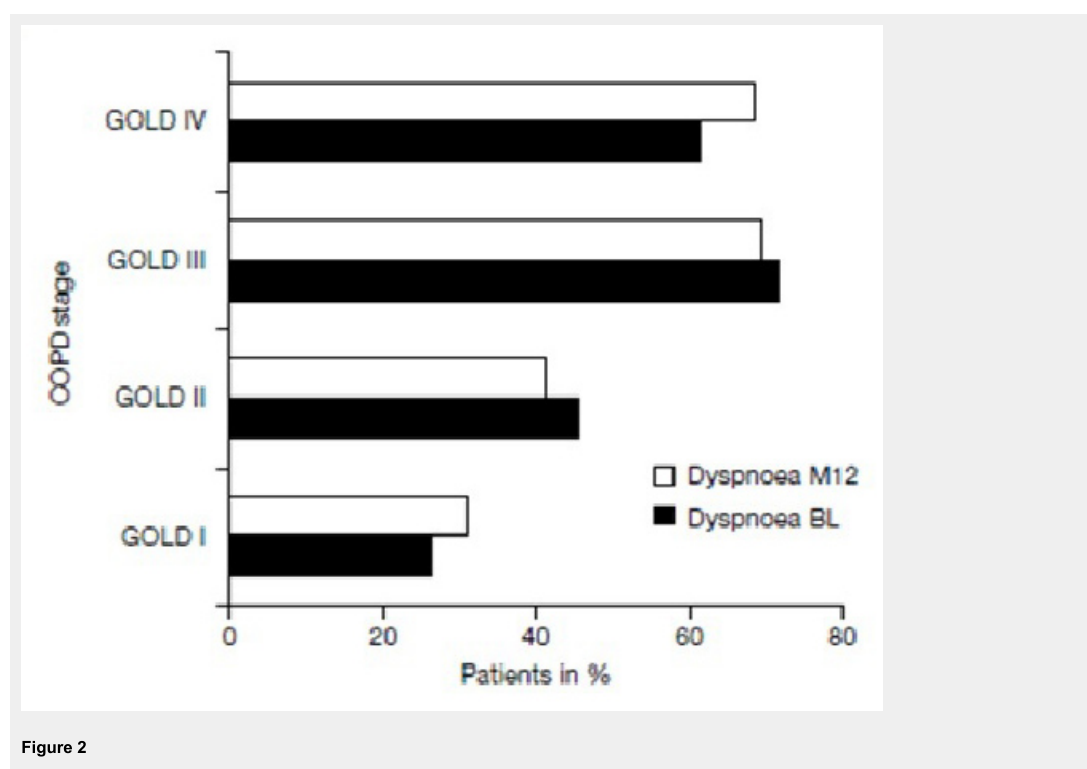
Figure 2 Prevalence of dyspnoea, after 12 months. Comparison of prevalence of dyspnoea at BL and after 12 months. No significant reduction after 12 months p = 0.24420. Abbreviations: COPD, chronic obstructive pulmonary disease; GOLD, Global Initiative for Chronic Obstructive Lung Disease; BL, baseline; M12, month 12.